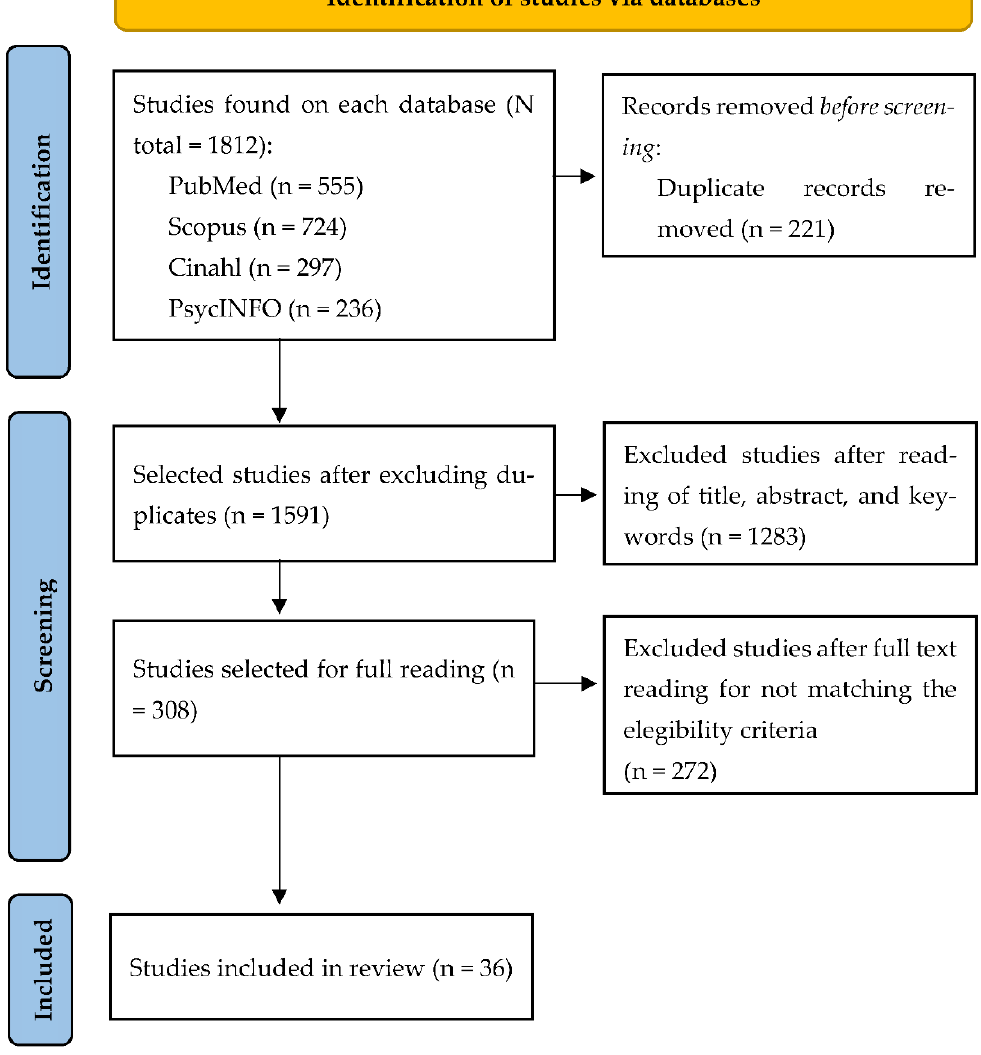
Figure 1. Selection of studies flowchart.